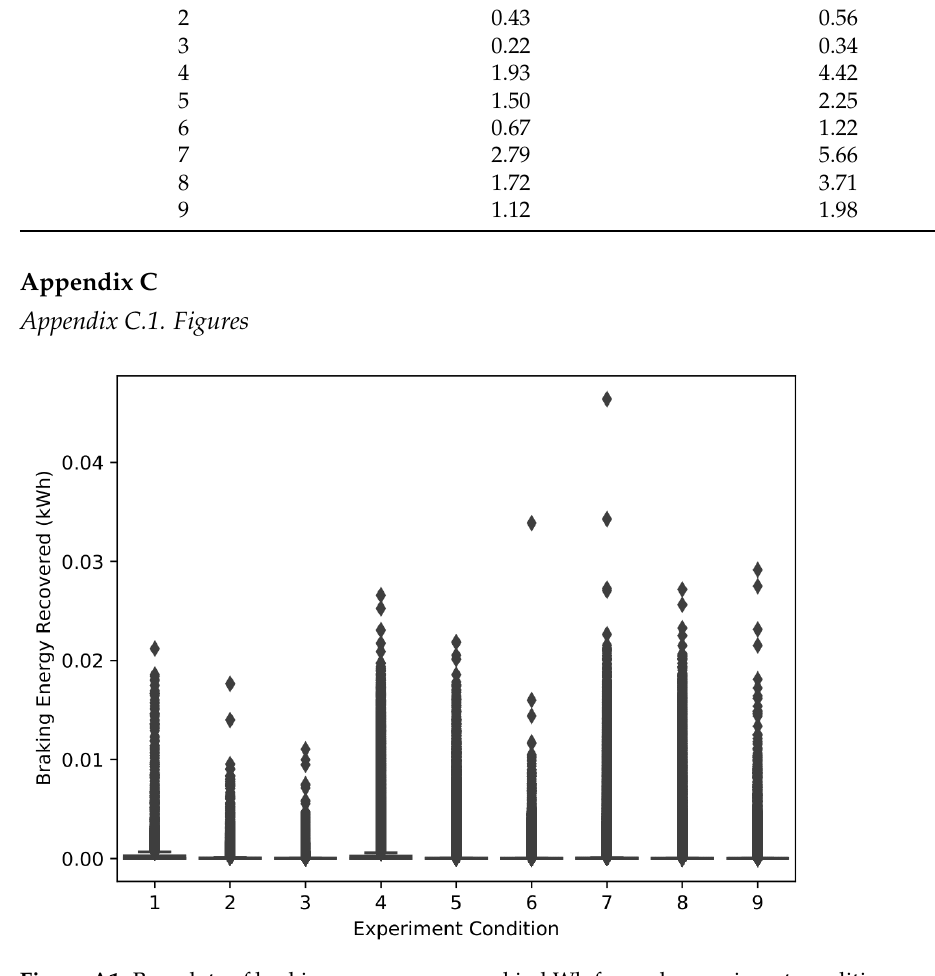
Figure A1. Box plots of braking energy recovered in kWh for each experiment